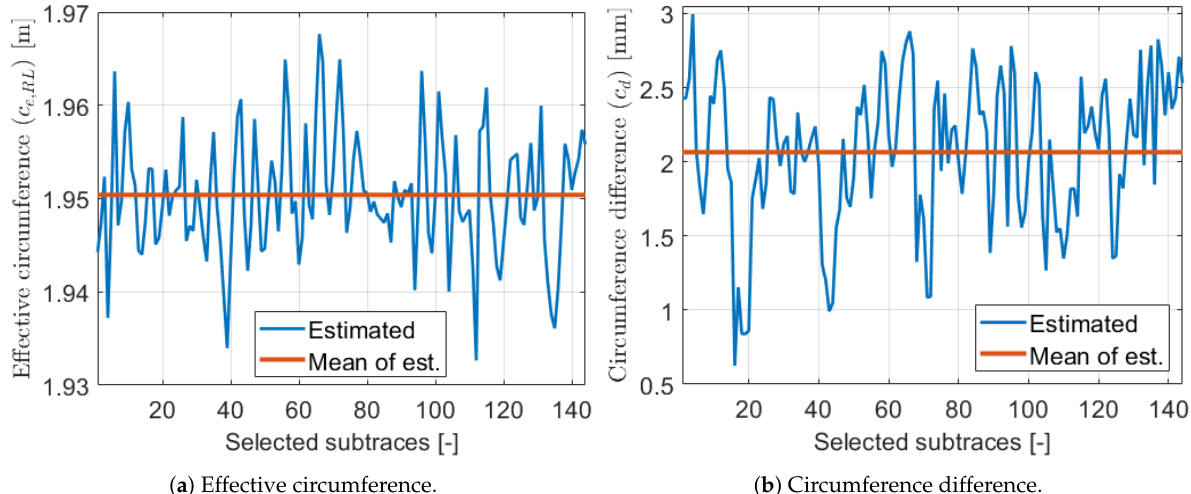
Figure 21. Estimated parameters 1.